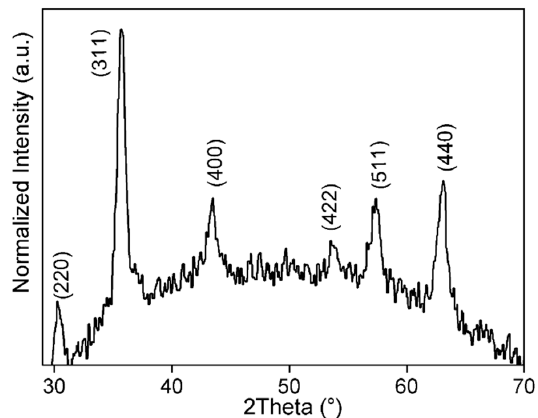
Figure 1. XRD pattern for synthesized bare magnetic nanoparticles (MNPs.)